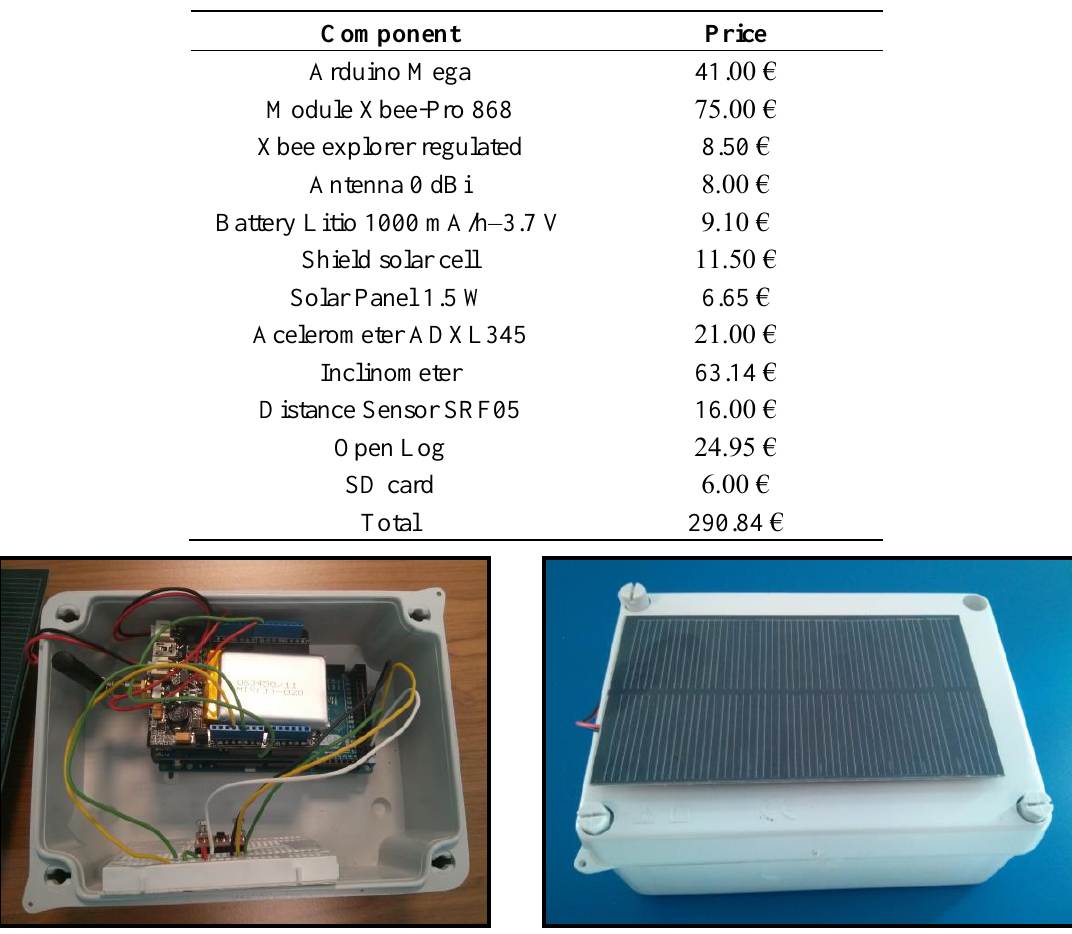
Table 11. Selected components.